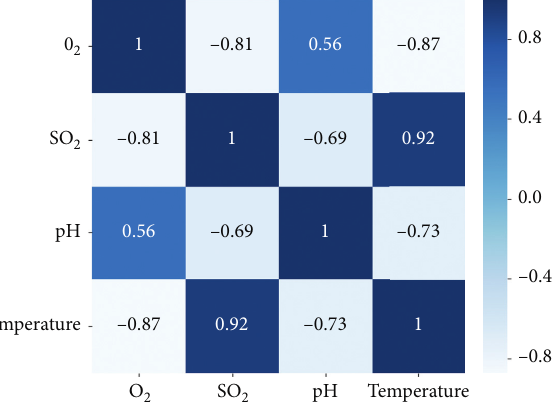
Figure 2: Correlation matrix of four output